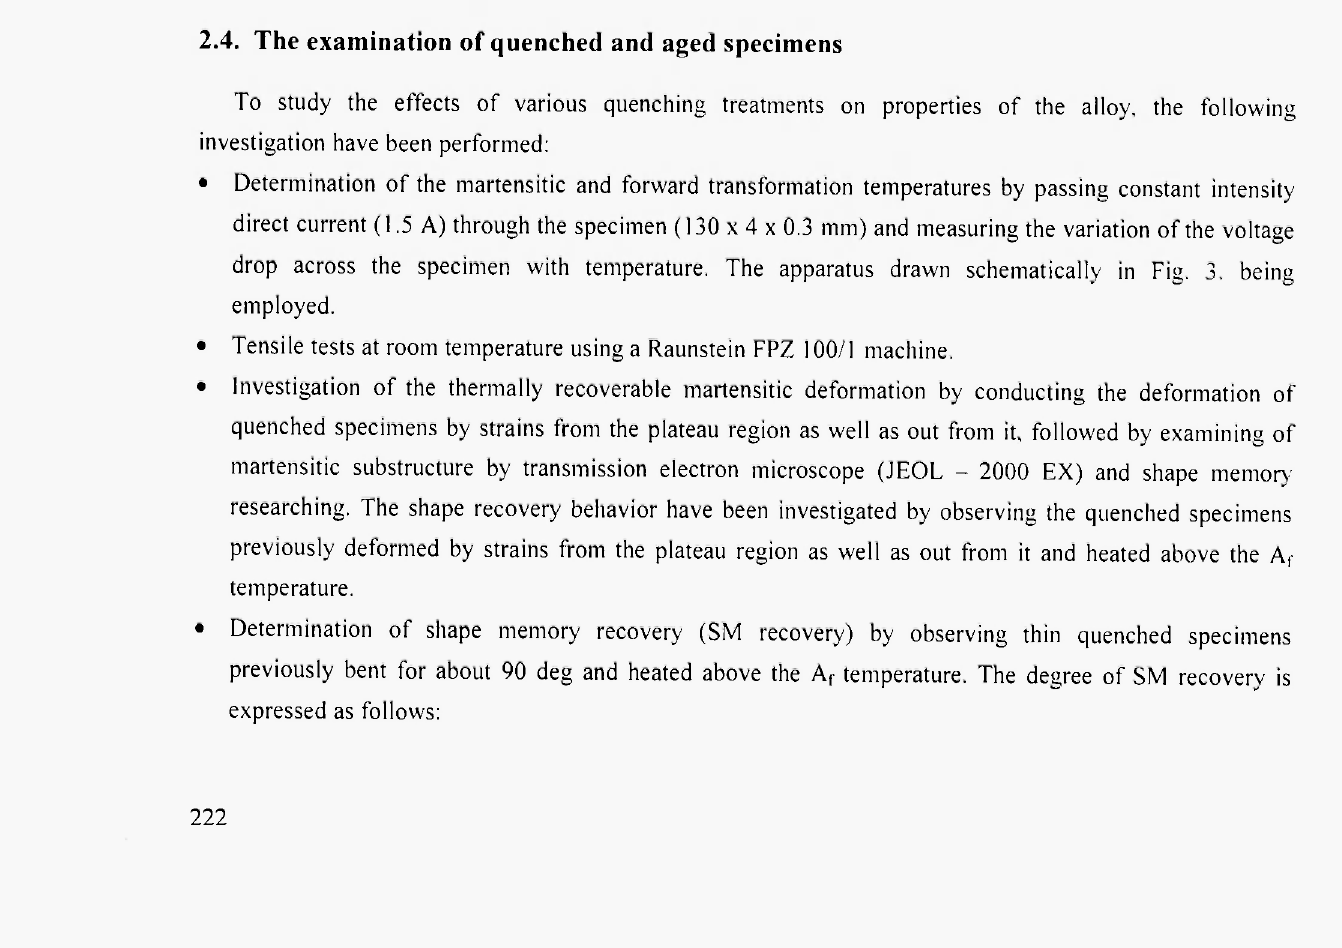
Fig. 2: Schematic illustration of various quenching